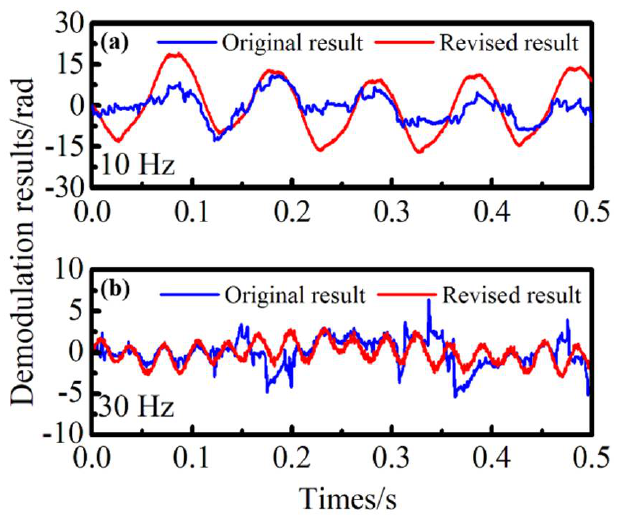
Figure 8. Comparison of time domain demodulation results at 10 Hz and 30 Hz.